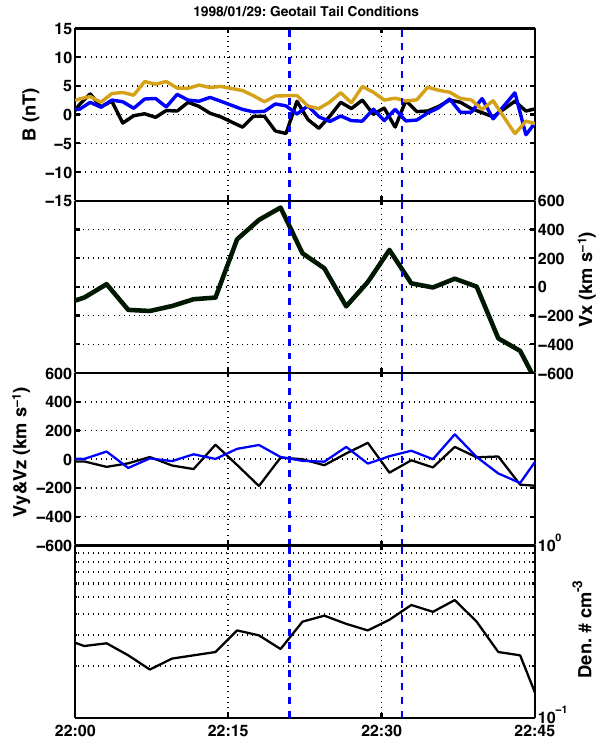
Figure 9. Geotail magnetic field and plasma data for 29 January 1998. The top panel shows the magnetic field in GSM coordinates. The black curve is the B X component, the orange curve is the B Y component, and the blue curve is the B Z component. The second panel shows the V X component of the flow and the third panel dis- plays the V Y (black curve) and V Z (blue curve) components. The bottom panel displays the particle density. The dashed vertical lines mark the start and end of the omega band observations at ABK and